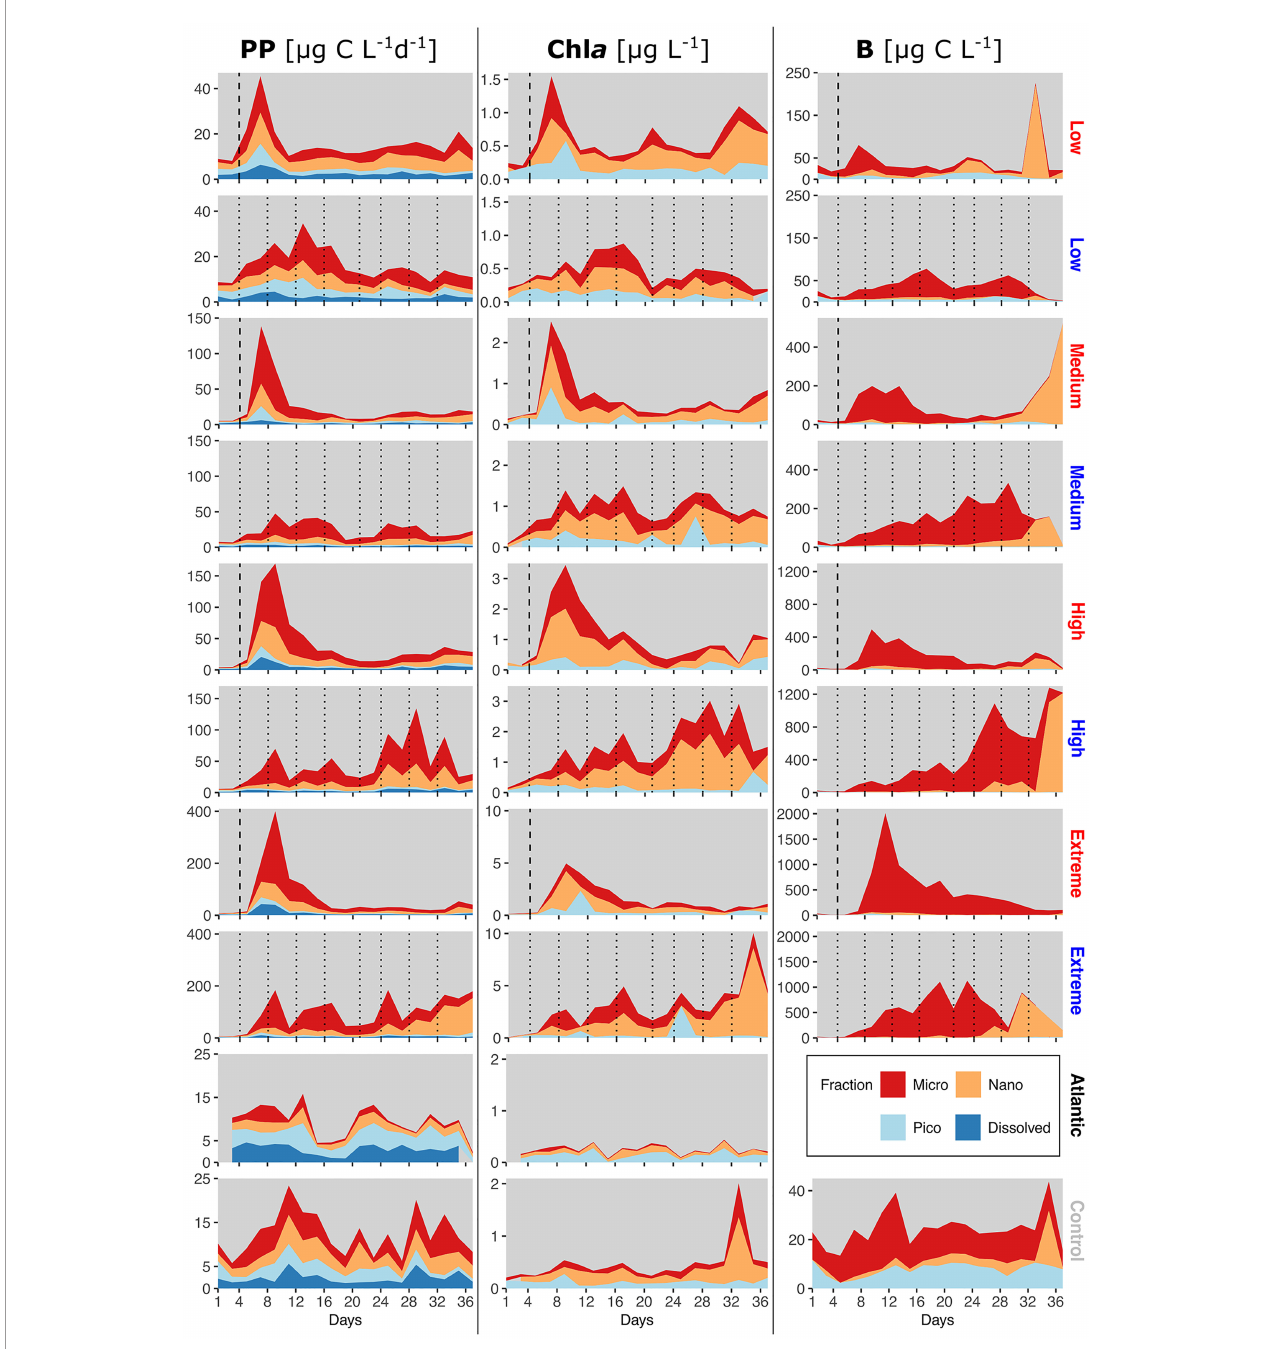
FIGURE 4 | Relative size class contributions of micro-, nano- and picoplankton to total PP rates, Chla concentration and phytoplankton C. PP plots also include PP DOC rates. Mind the different y-axis scales. The blank spot in the Atlantic between d35-37 is due to one missing data point. Dotted lines represent DW additions, dashed line marks the single DW addition to singular treatments. Recurring treatments labelled in blue, singular in